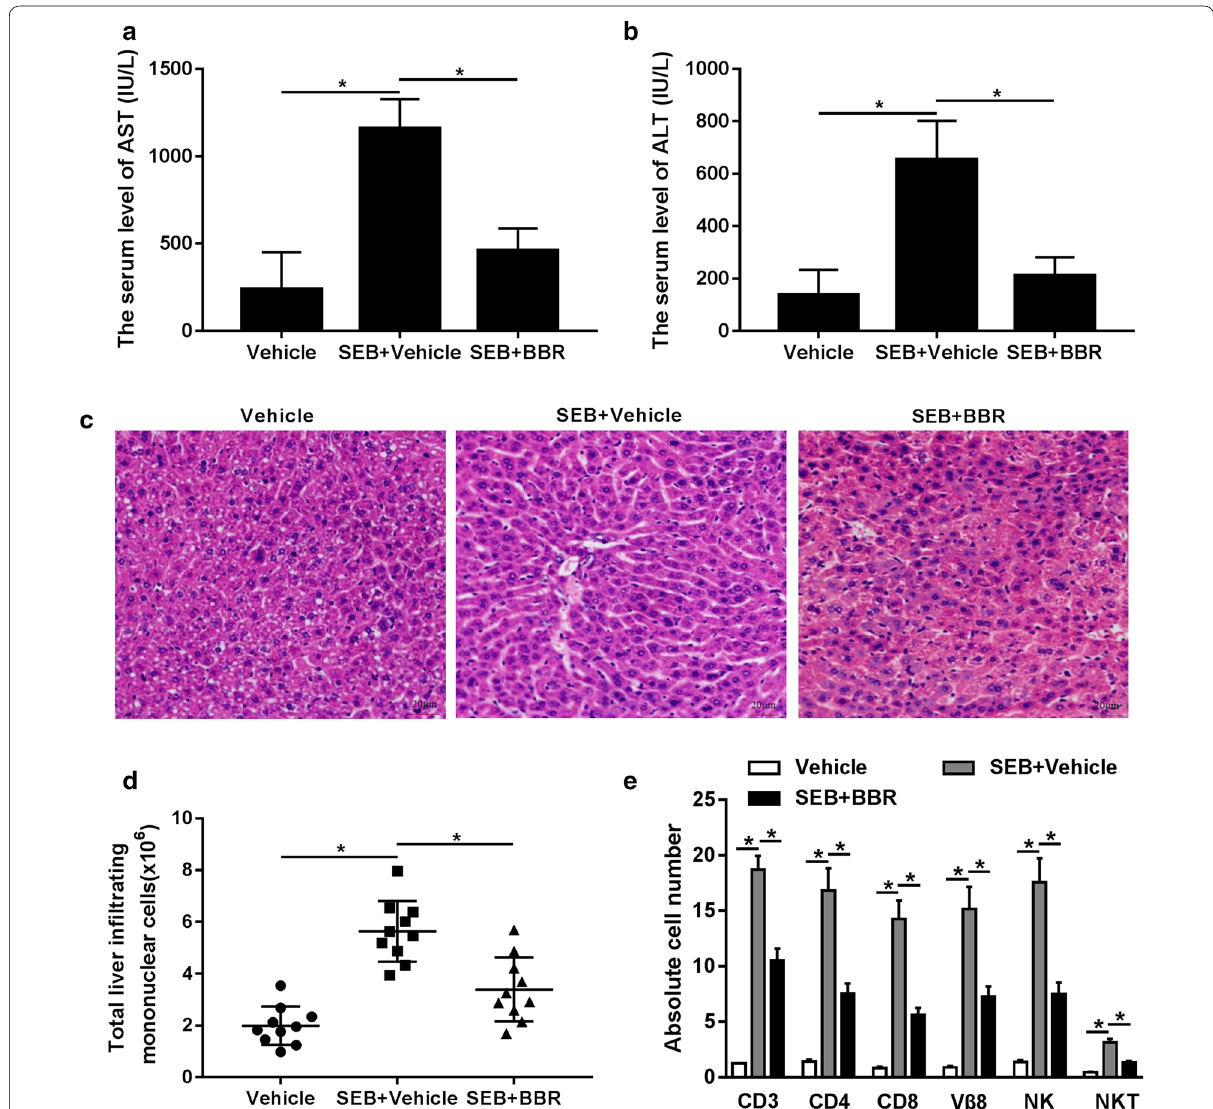
Fig. 1 BBR attenuated SEB-induced ALI in mice. a , b The serum levels of ALT and AST were determined. c Histopathological examination of the liver tissues was conducted by HE staining. d Liver-infiltrating mononuclear cells were counted. e The liver infiltrating mononuclear cells were stained with monoclonal antibodies to determine the following subsets: T cells (CD3), T-helper cells (CD4), T-cytotoxic cells (CD8), natural killer cells (NK), and natural killer T-cells (NKT). * P < 0.05. SEB Vehicle group versus Vehicle or SEB BBR group, + +